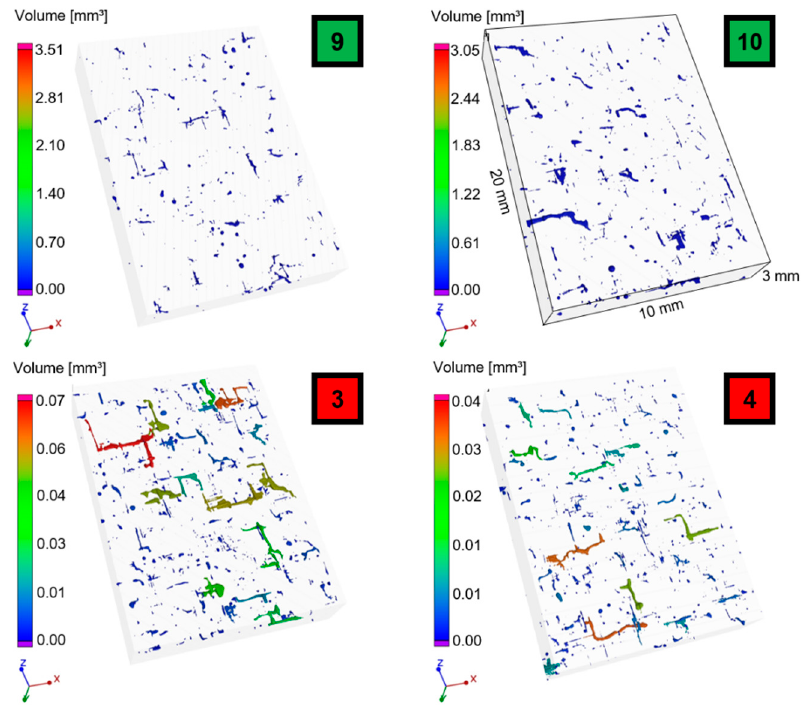
Figure 5. µCT analysis of calculated local pore volume and its distribution in the center area of bending specimen with fiber orientation of 0/90°, sample #9 and #10 from homogeneous area, sample #3 and #4 from inhomogeneous area.